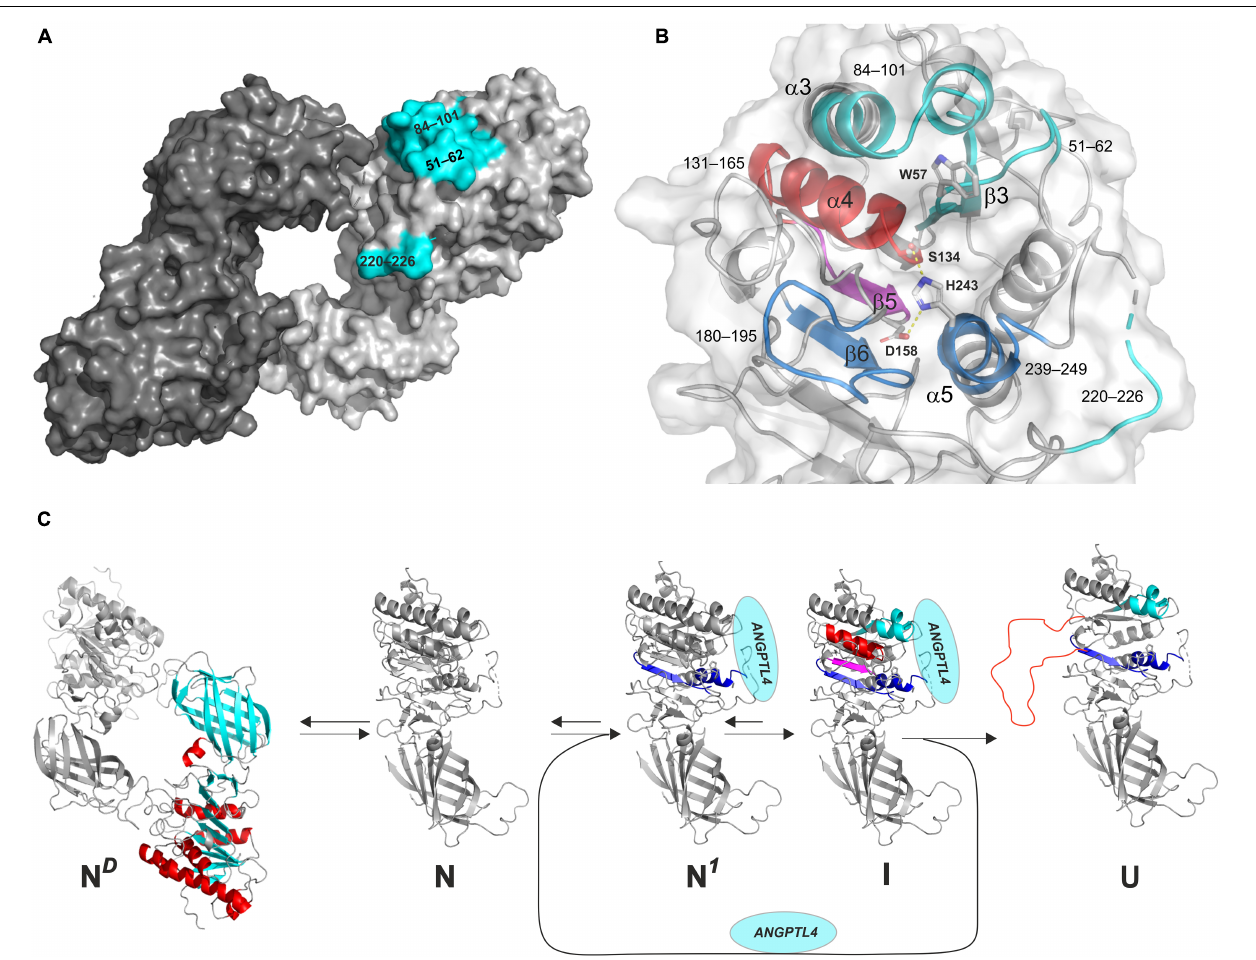
FIGURE 5 | Model of the irreversible inhibition of LPL by ANGPTL4-catalyzed unfolding. (A) The ANGPTL4 binding site on LPL is highlighted in cyan on the surface representation of one of the protomers in the head-to-tail homodimer structure of LPL solved by X-ray crystal structure. (B) The architecture of the catalytic triad as a combined surface and cartoon representation. Regions involved in ANPTL4 binding (51–62 [ β 3], 84–101 [ α 3], and 220–226 [lid]) are cyan ; regions where ANGPTL4 binding triggers increased dynamics by allostery are blue (180–195 [ β 6] and 239–249 [ α 5]) and purple (147–165 [ β 5]); and regions where irreversible unfolding represents the point-of-no-return inexorably leading to permanent LPL inhibition are red (133–145 [ α 4]). The catalytic triad is shown as sticks (Ser 134 , Asp 158 , and His 243 ). (C) The reaction sequence of ANGPTL4-catalyzed unfolding of LPL’s α / β -hydrolase domain, leading to irreversible collapse of the catalytic pocket. N D : the native state of LPL homodimer; N: native state of LPL monomer; N 1 : native state of LPL in complex with ANGPTL4 with increased flexibility of α 5 and β 6 ( blue ); I: intermediate state of LPL with increased flexibility of β 5 ( purple ) and reversible unfolding of α 4 ( red ); U: unfolded state of LPL with irreversible unfolding of α 4 ( red